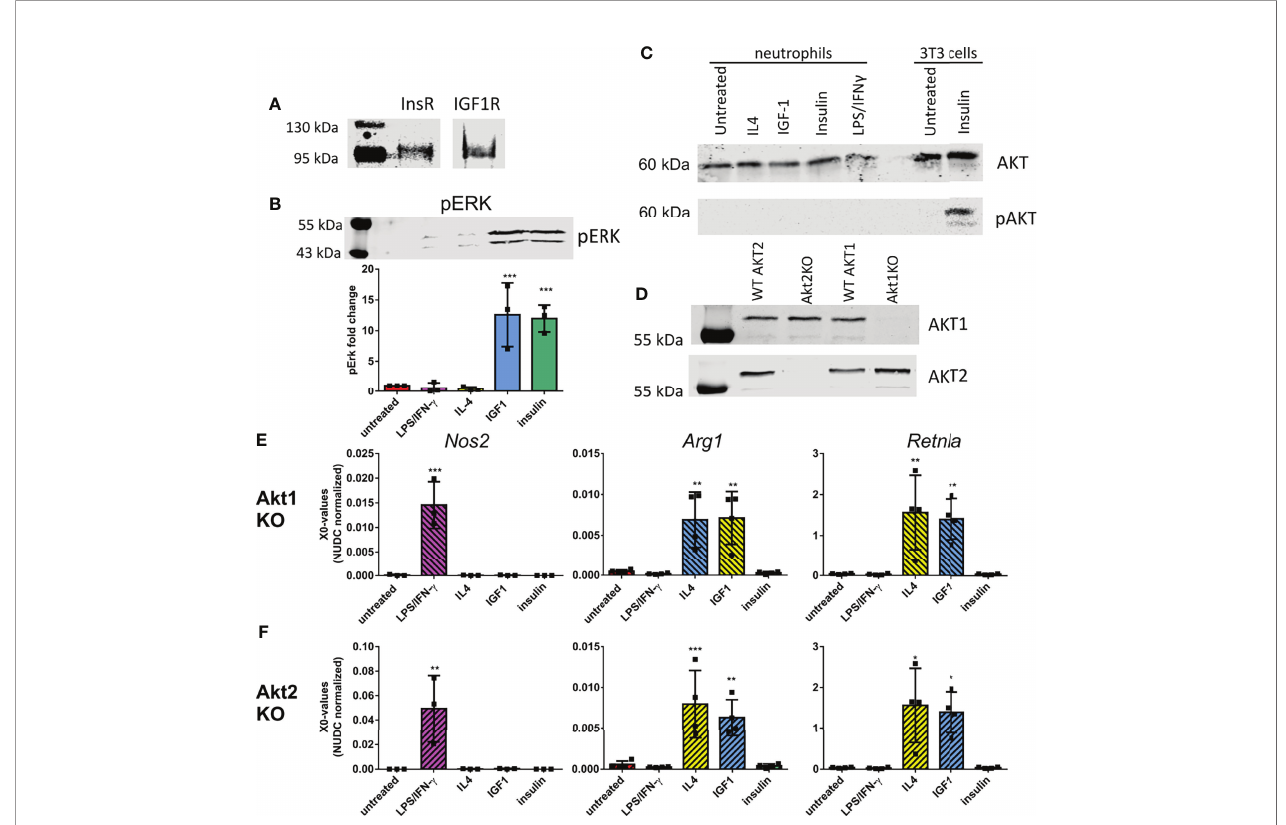
FIGURE 3 | Neutrophil polarization is not caused by activation of the known IGF1 pathways (A) Immunoprecipitation showed the presence of the insulin-like growth factor 1 receptor (IGF1R) and insulin receptor (InsR) in bone marrow derived neutrophils (B) 10 min IGF1 and insulin treatment caused phosphorylation of ERK (pERK) as shown by western blot. Data is normalized to pERK in untreated neutrophils. (C) Western blot analysis showed the presence of AKT in bone marrow derived neutrophils, however none of our treatments caused AKT phosphorylation (pAKT) after 10 min treatment. As a positive control AKT phosphorylation of 3T3 cells after insulin treatment is shown on the same western blot. (D) Akt1 and 2 expression in Tie2-Cre Akt1 fl / fl and Tie2-Cre Akt2 fl / fl mice was assessed by Western blot. (E-F) N1 and N2 polarization after our treatments was unaffected in Tie2-Cre Akt1 fl / fl (E) and Tie2-Cre Akt2 fl / fl (F) neutrophils as shown by normal upregulation in quantitative RT-PCR of Nos2 after LPS/IFN g treatment and Arg1 and Retnla after IL4 and IGF1 treatment. LPS: Lipopolysaccharide, IFN g : interferon-gamma, IL4: Interleukin 4, IGF1: Insulin-like growth factor 1, Nos2 : nitric oxide synthase 2, Arg1 : Arginase 1, Retnla : resistin like alpha. X0 values normalized to Nudc (nudC nuclear distribution protein) expression of single measurements are shown. Bars represent mean ± SD. *p<0.05, **p<0.01,